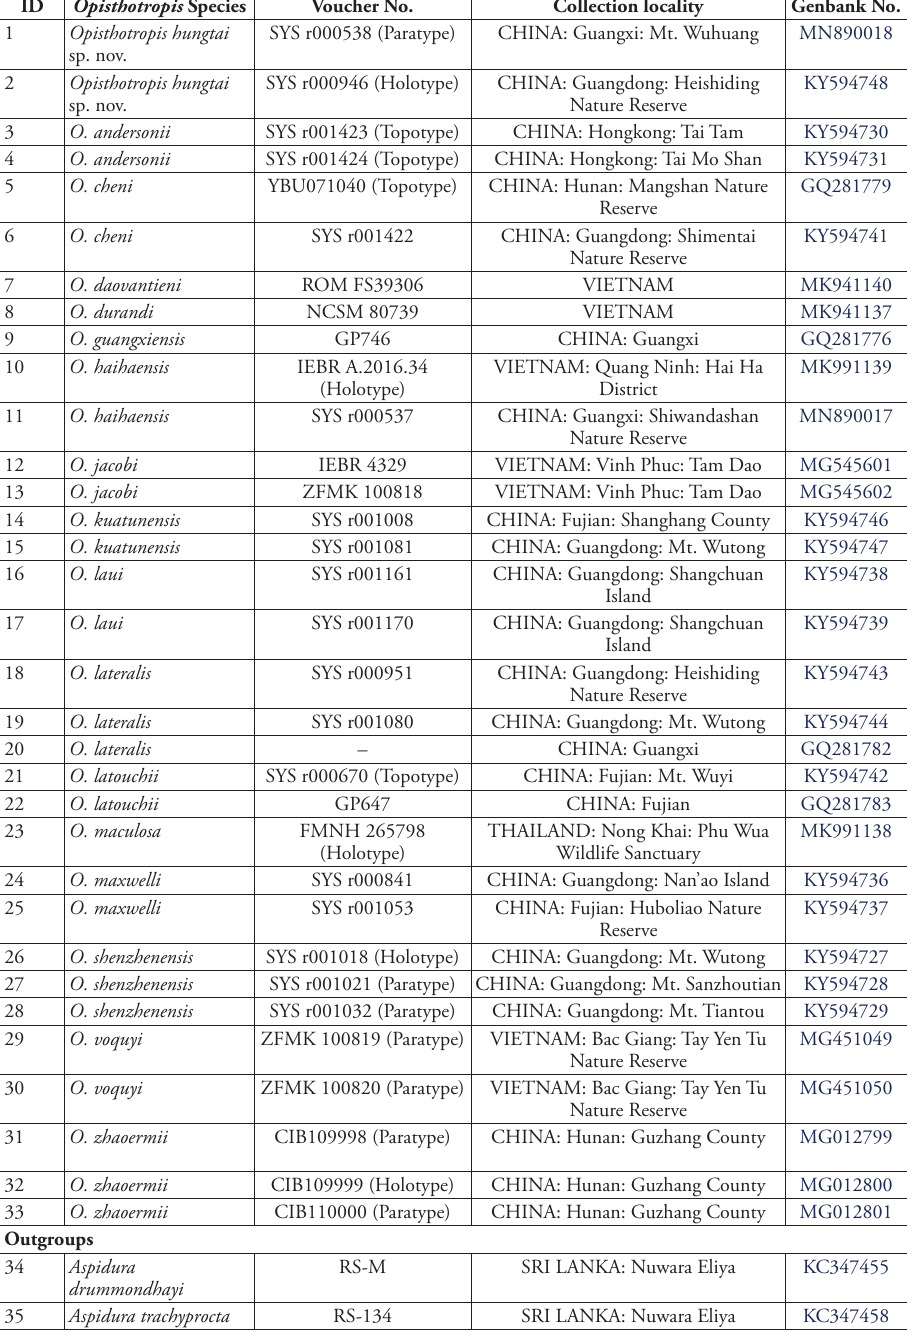
Table 1. Localities, voucher information, and GenBank numbers for all samples used in this